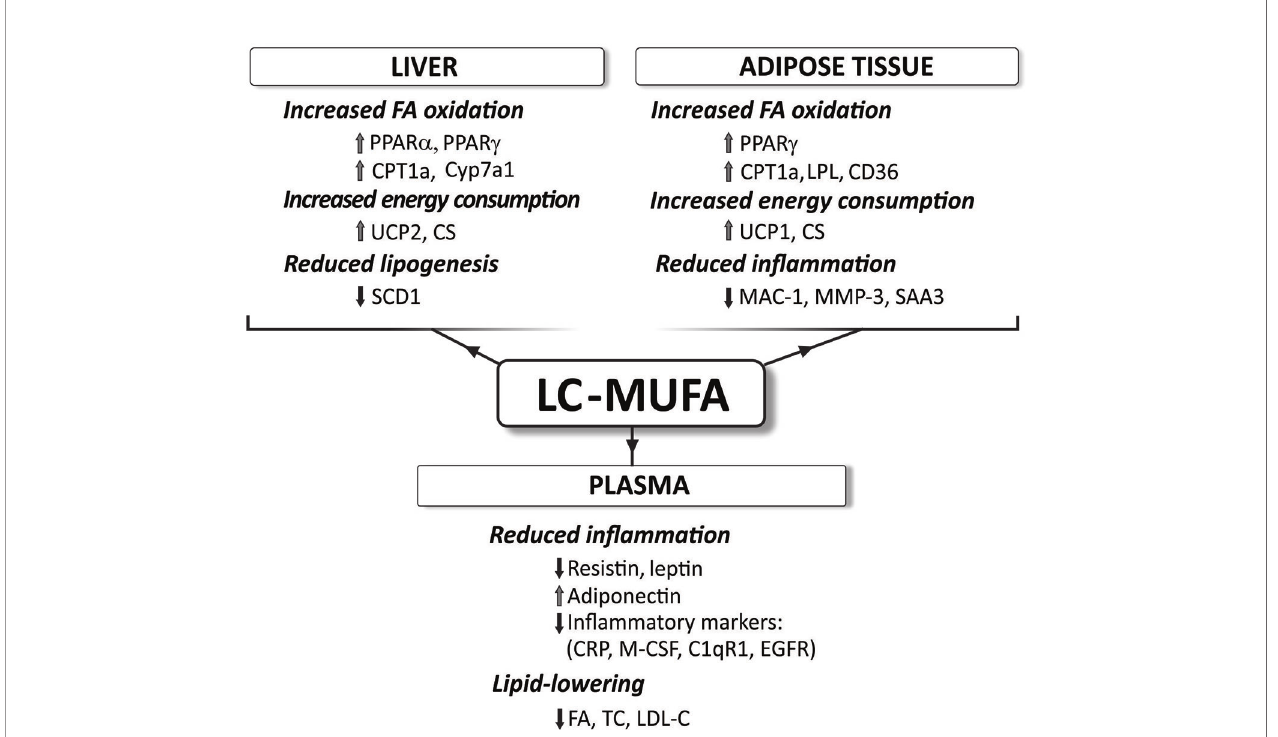
FIGURE 5 | Reported effects of concentrated LC-MUFA on gene expression related to fatty acid oxidation, energy consumption, lipogenesis, and in fl ammation in the liver and adipose tissue, as well as plasma levels of various compounds. C1qR1, complement component 1q receptor; CD36, fatty acid translocase; CPT1a, carnitine palmitoyltransferase 1a; CRP, C-reactive protein; CS, citrate synthase; CyP7a1, cholesterol 7 alpha-hydroxylase (cytochrome P450 7A1); EFGR, epidermal growth factor receptor; FA, free fatty acids; LDL-C, low-density lipoprotein cholesterol; LPL, lipoprotein lipase; MAC-1, macrophage-1 antigen; M-CSF, macrophage colony-stimulating factor; MMP-3, matrix metalloproteinase-3; PPAR, peroxisome proliferator-activated receptor; SAA3, serum amyloid A3; SCD-1, stearoyl-CoA desaturase-1; TC, total cholesterol; UCP, uncoupling protein (summarized from Yang et al., 2011d; Yang et al., 2013; Yang et al., 2015; Yang et al., 2016a; Yang et al.,